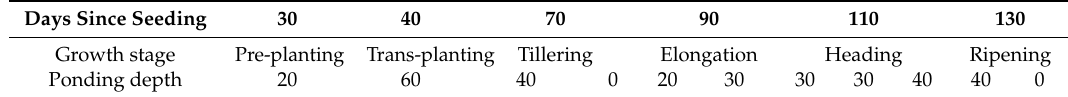
Table 3. Desirable ponding depth by growth stages for rice paddy